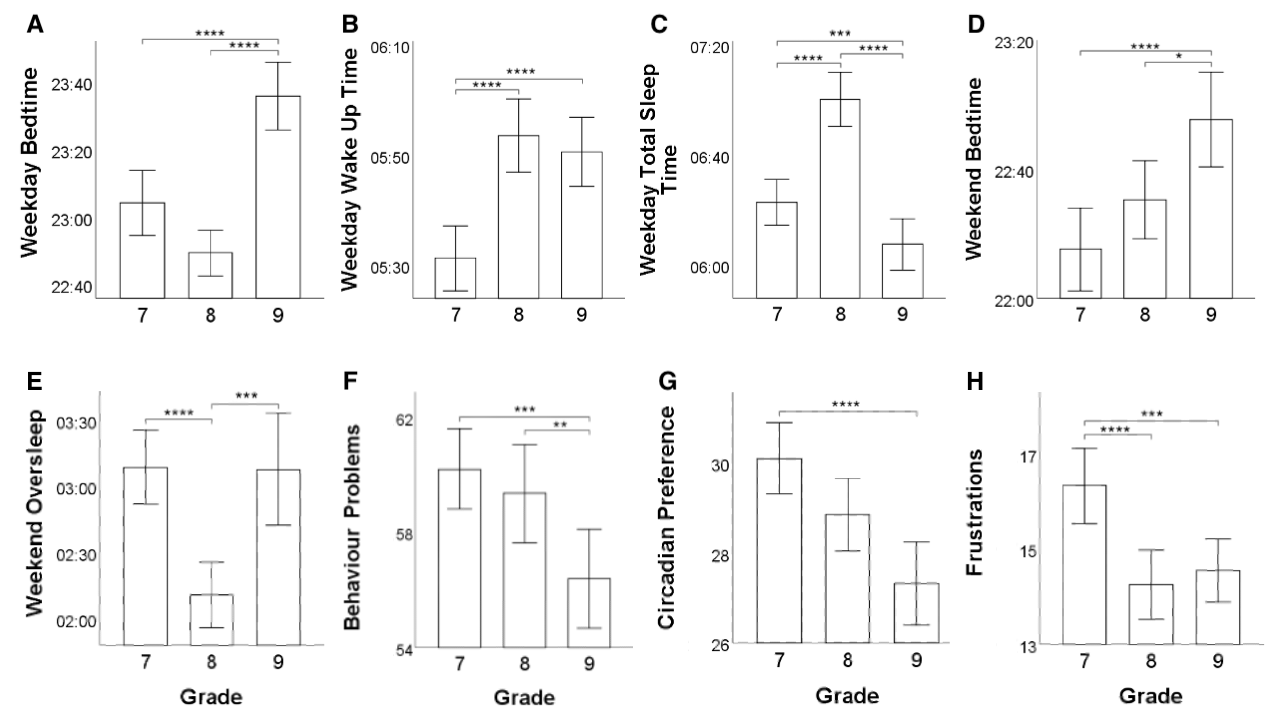
Figure 1. Bar plots representing the significant differences in terms of sleep patterns and academic stress across school grade groups. Specifically, the figure reports differences across school grades in terms of: ( A ) weekday bedtime; ( B ) weekday wake up time; ( C ) weekday total sleep time; ( D ) week- end bedtime; ( E ) weekend oversleep; ( F ) sleep/wake behaviour problems; ( G ) circadian preference; and ( H ) stress derived from frustrations (* p < 0.017; ** p < 0.01; *** p < 0.001; **** p <